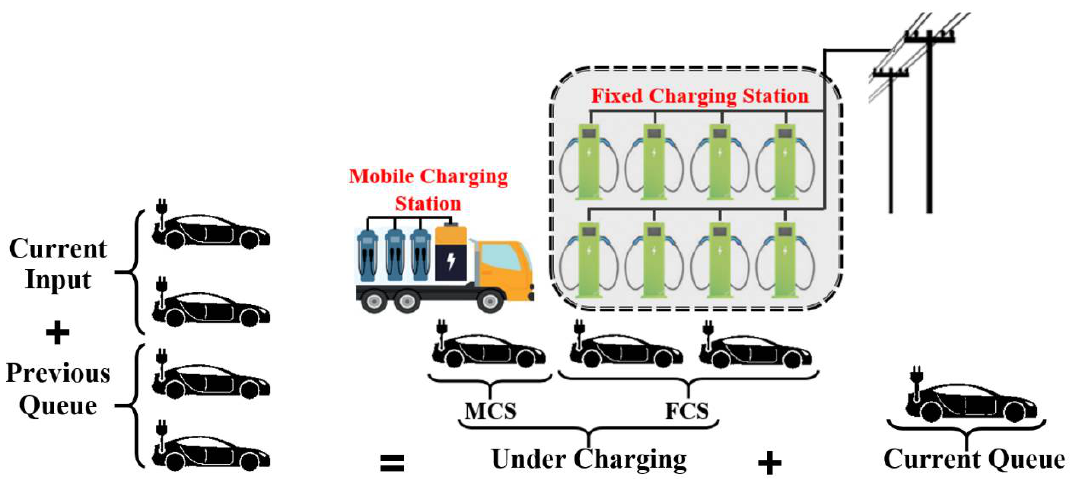
Figure 2. Relation between input, under charging, and queue of the EVs in the FCS.